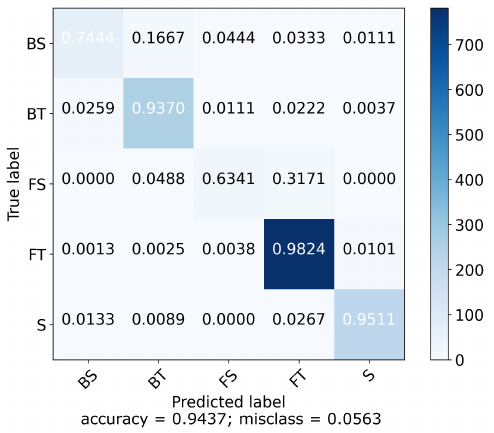
Figure 13. Normalized confusion matrix for the best ResNet comparing the five classes: backhand slice (BS), backhand topspin (BT), forehand slice (FS), forehand topspin (FT), and service